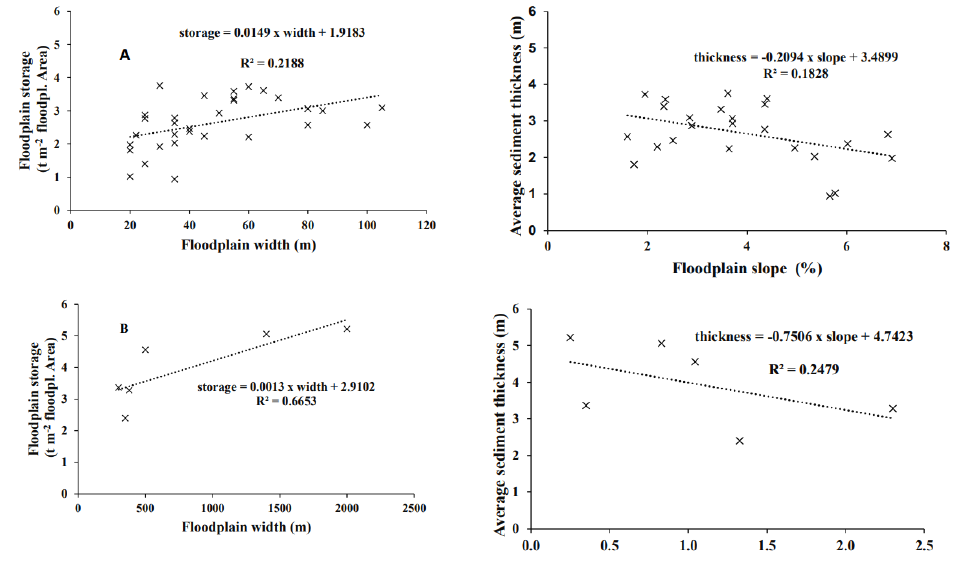
Figure 5. Relations of floodplain storage and mean sediment thickness in function of floodplain width and slope for Chencha ( A ) and Dembelle ( B ).